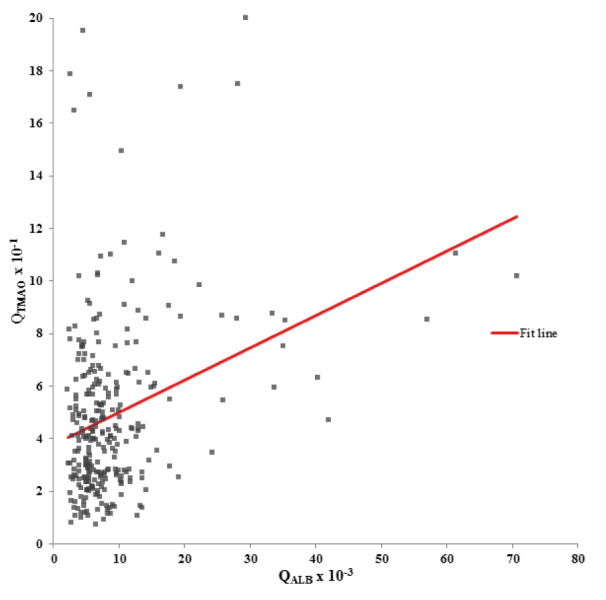
Univariate regression model between the cerebrospinal fluid (CSF)/serum trimethylamine-N-oxide (TMAO) quotient (QTMAO) and the CSF/serum albumin quotient (QALB). ß-coefficient = 0.312, p < 0.001.